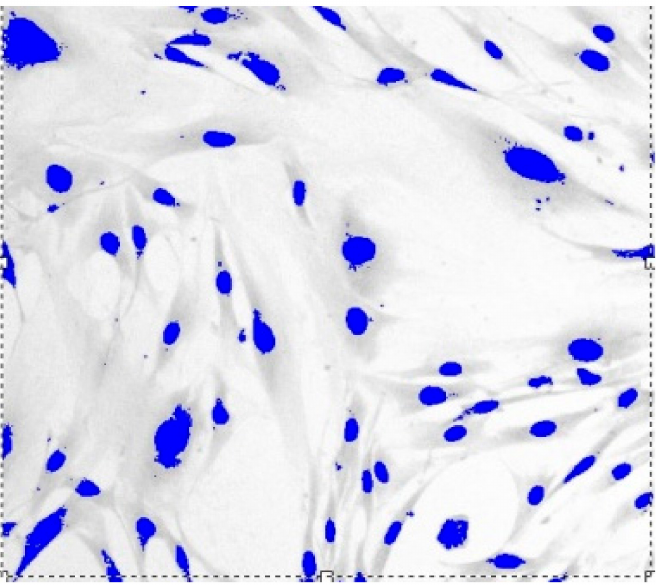
Figure 3. Fibroblasts E = 500 J, t = three days, D = 1.571 ± 0.0081, Sudan IV and hematoxylin-eosin staining, magnification n = 200.